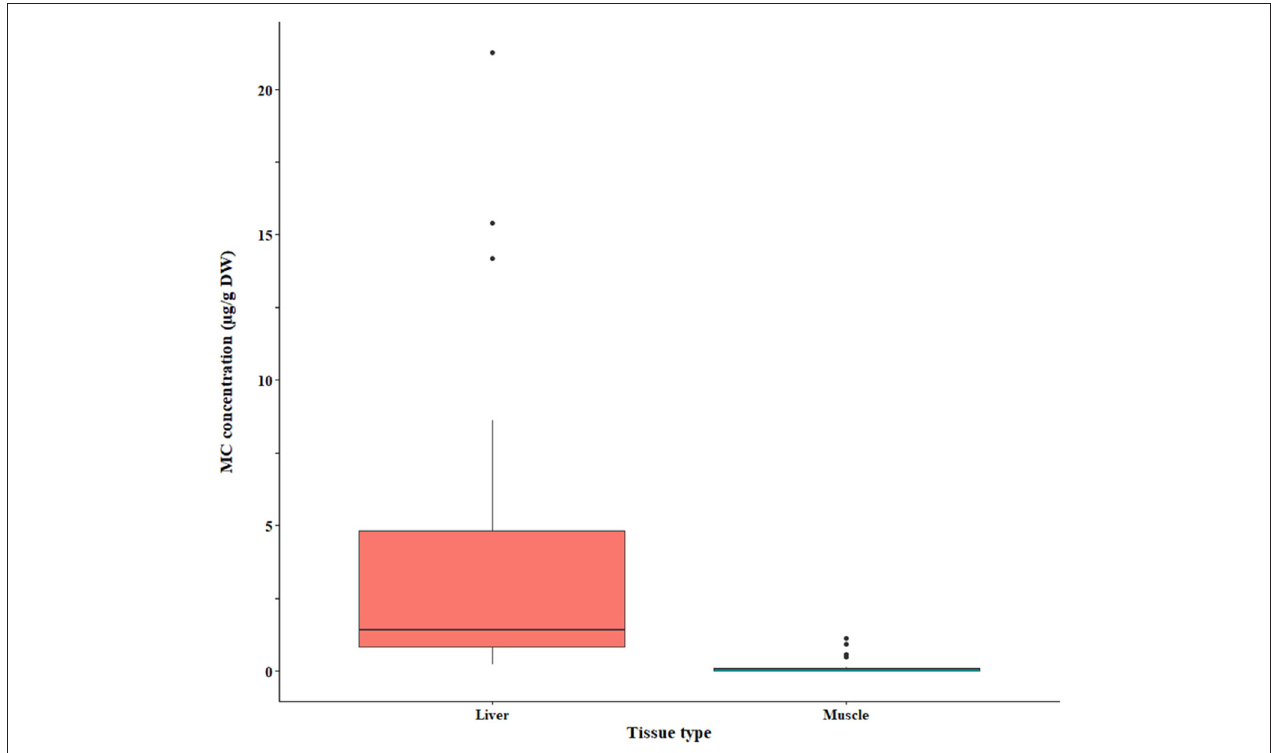
FIGURE 7 | Microcystin (MC) concentrations in fish liver and muscle quantified by the GC-MS (MMPB) method. The raw data are shown.